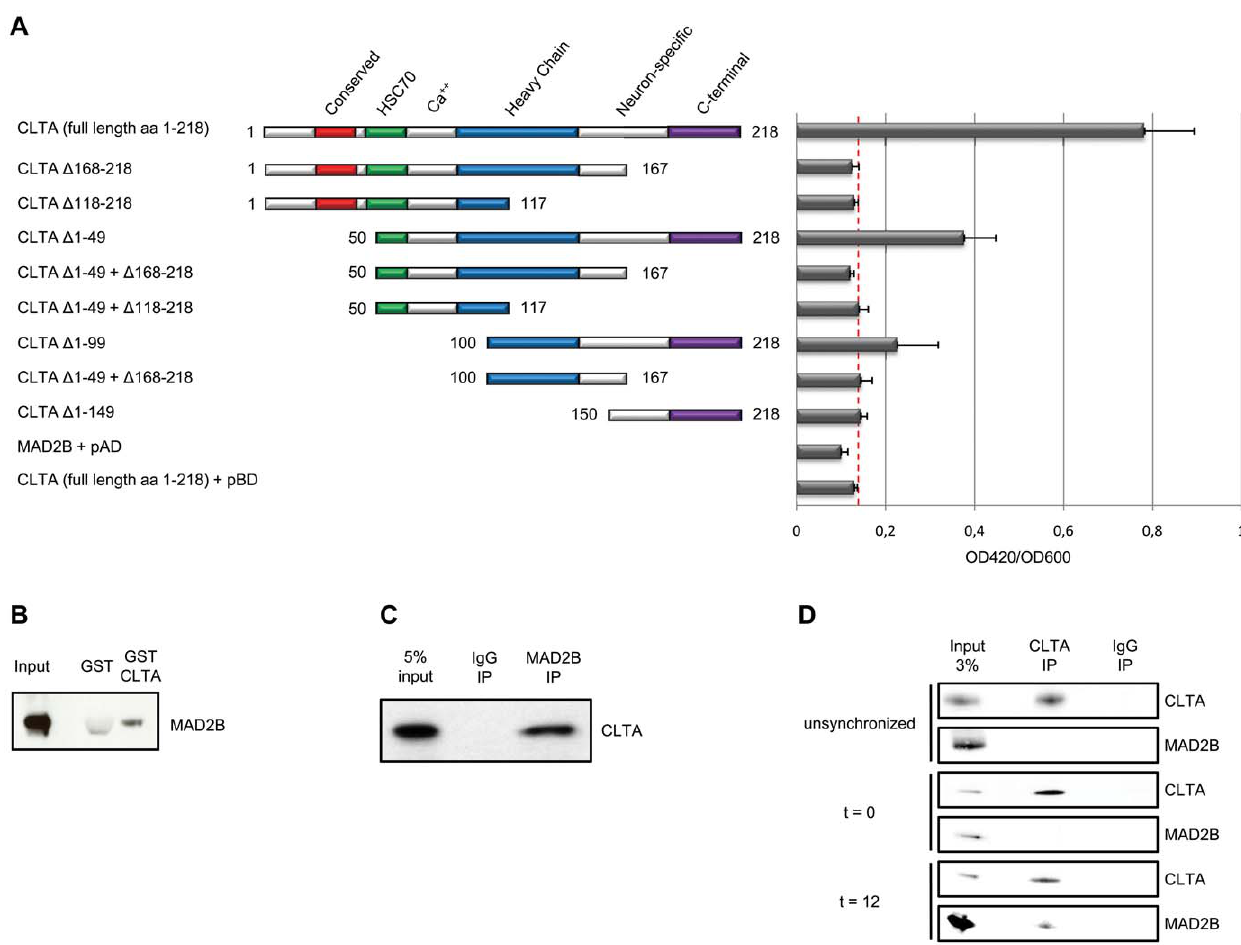
Figure 1. MAD2B and CLTA interact physically. (A) Schematic representation of the CLTA (deletion) constructs (numbers correspond to amino acid positions) and corresponding interactions with MAD2B measured as OD420/OD600 ratios using a liquid b -galactosidase assay. (B) HA-MAD2B protein was probed for interaction with either GST or GST-CLTA. Subsequent western blot analysis was performed using an anti-HA tag antibody. (C) U2OS cells were transiently transfected with HA-MAD2B and FLAG-CLTA. Immunoprecipitations (IP) were performed with a control rabbit antibody (IgG) and an anti-MAD2B antibody as indicated. Western blot analysis was performed using an anti-FLAG antibody. (D) U2OS cells were synchronized by a double thymidine block (see Materials and methods) and subsequently harvested at different time intervals after release from this cell cycle block. Immunoprecipitations were performed on cell lysates from unsynchronized cells and from cells at t=0 and t=12 after release. Endogenous proteins were precipitated with an anti-CLTA and a control mouse antibody (IgG) as indicated. Western blot analysis was performed using anti-CLTA and anti-MAD2B antibodies.